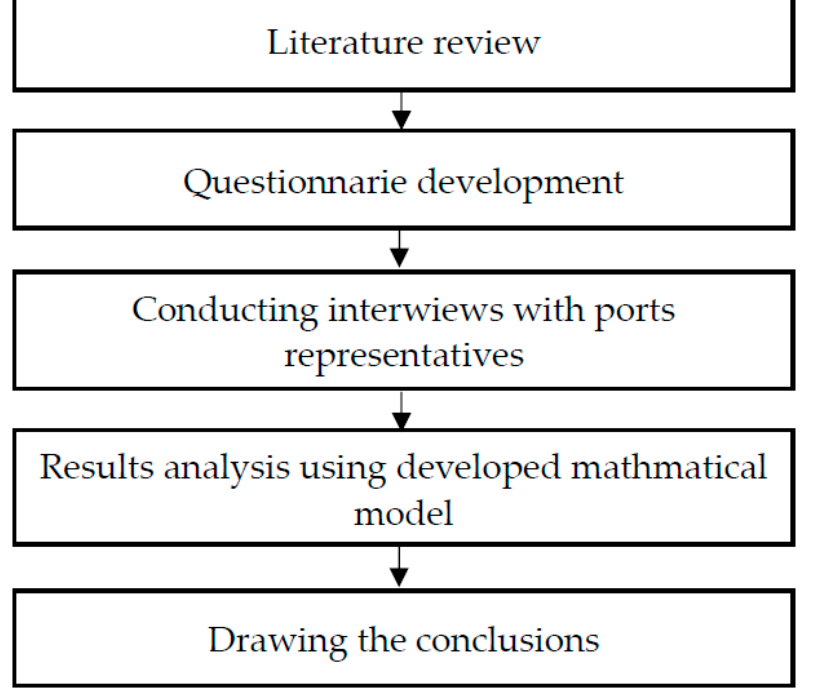
Figure 1. Research methodology.